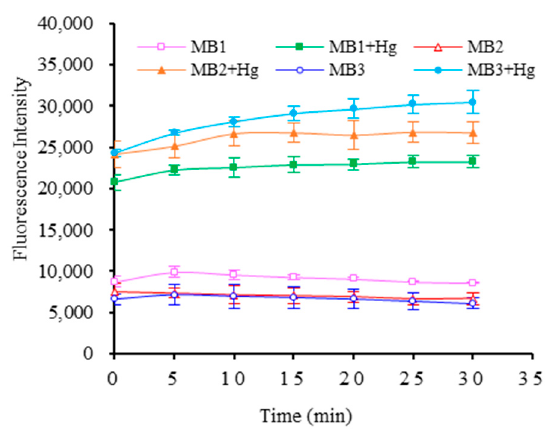
Figure 3. Fluorescence intensity of three molecular beacon aptamers responding to Hg 2+ .